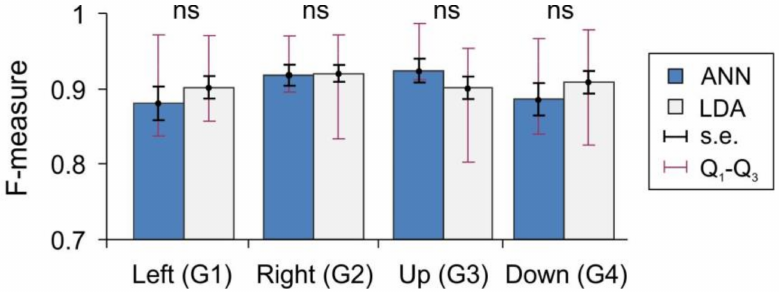
Figure 5. Two classifiers artificial neural network (ANN) and linear discriminant analysis (LDA) show similar recognition performance for gestures G 1 –G 4 (all differences are not significant,